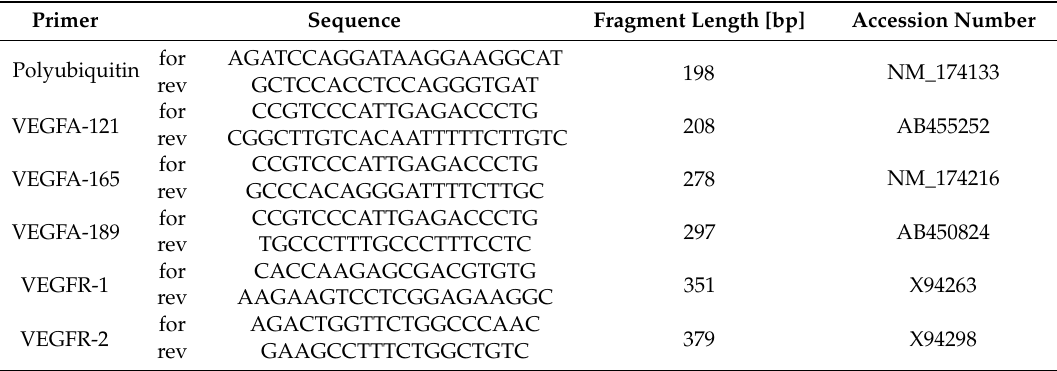
Table 2. Forward (for) and reverse (rev) primer sequences of the reference gene polyubiquitine, vascular endothelial growth factor A (VEGFA) isoforms and VEGF receptors (VEGFR-1 and VEGFR-2) for bovine used in quantitative reverse